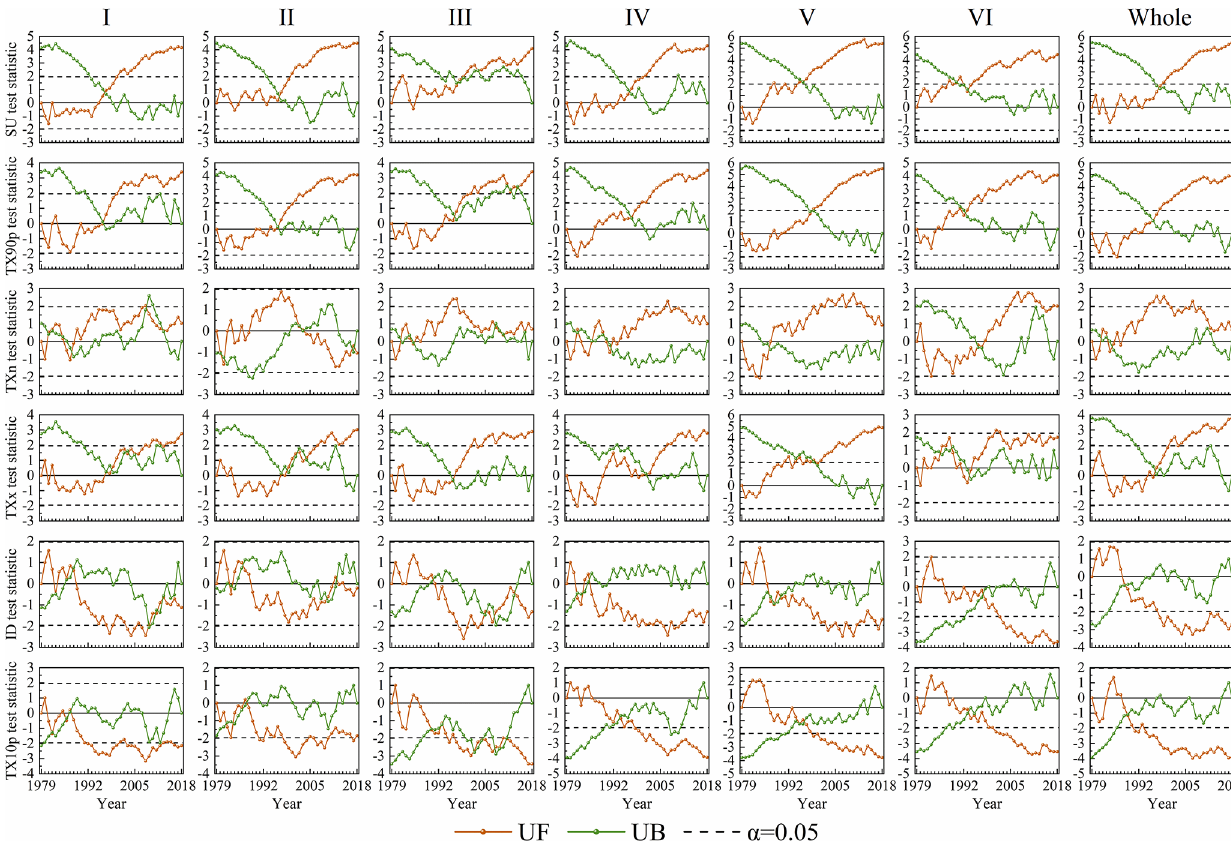
Figure 15. MK abrupt change detection for the extreme temperature indices in different regions of China during